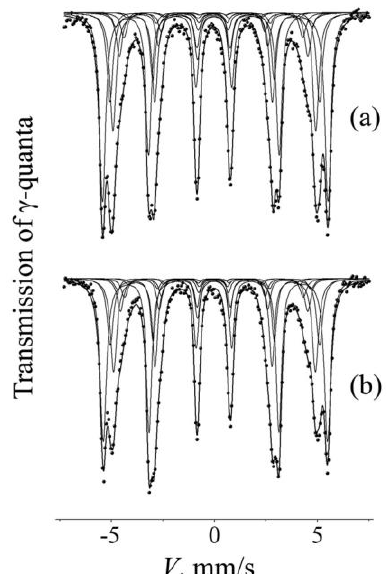
Figure 4. Spectra for the alloy Fe 94 Cr 6 . Treatment (state): ( a ) annealed at 1073 K (as-received) and aged at 773 K, 50 h; ( b ) aged and HPT (ε = 5.9, n = 3 rev.) at 80 K.